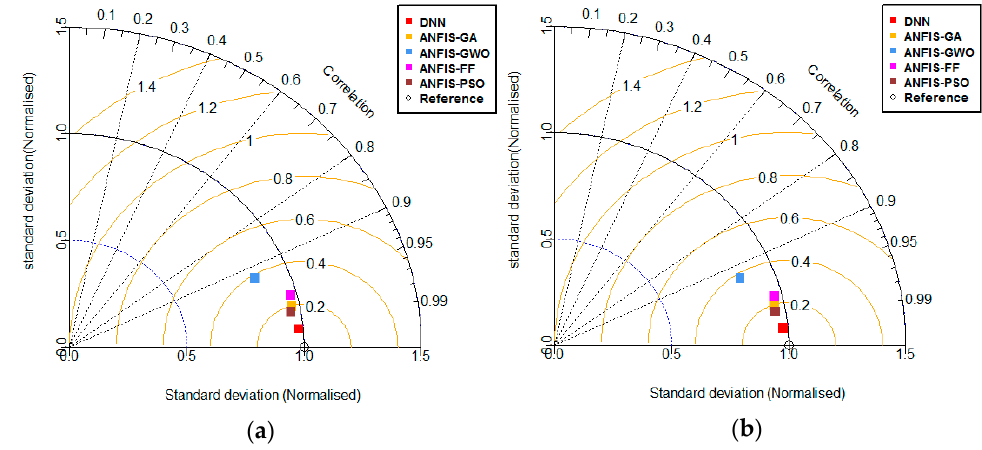
Figure 15. Taylor diagram in y direction ( a ) for training and ( b ) for testing phase.